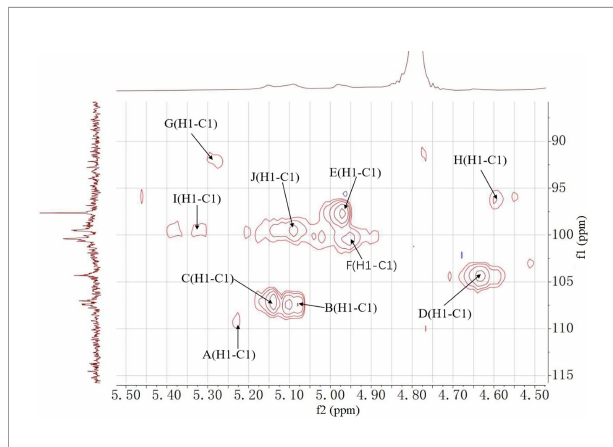
FIGURE 5 | HSQC spectrum of